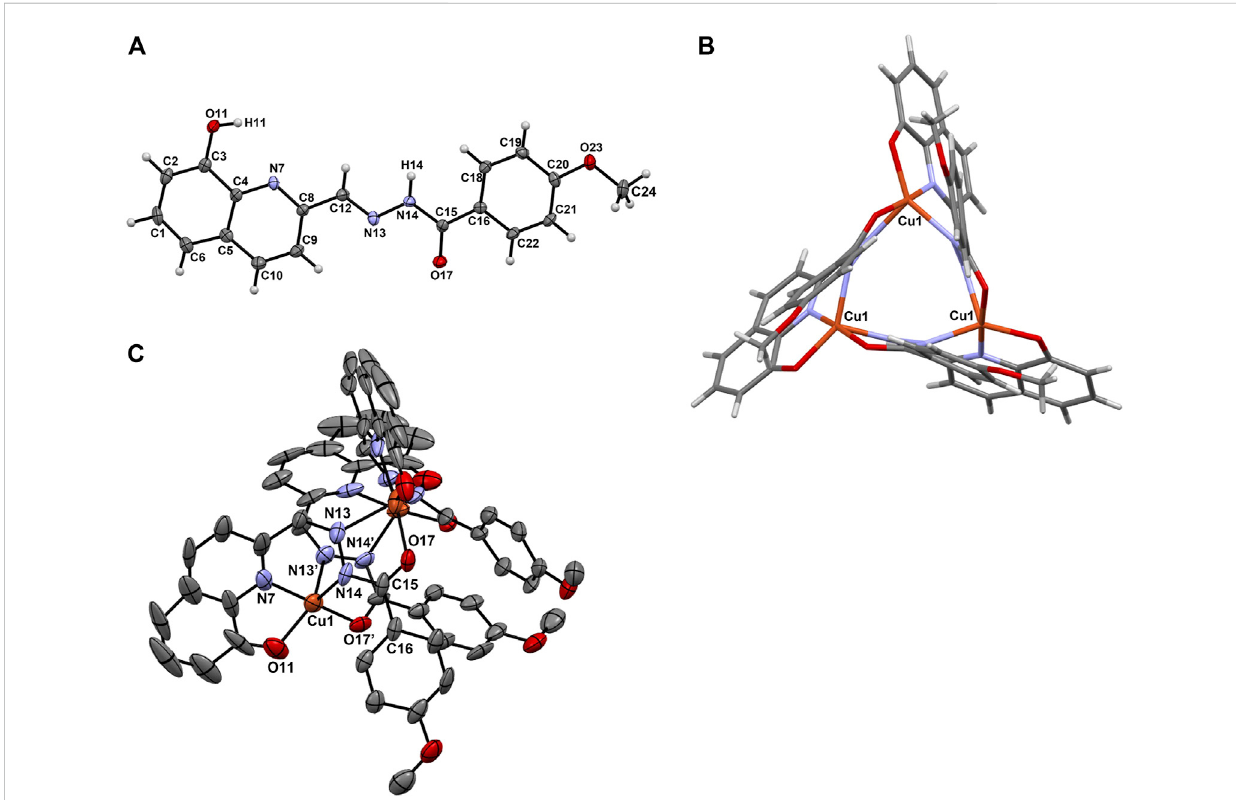
FIGURE 1 (A) ORTEP diagram of L 5 with thermal ellipsoids at 40% probability level along with the atom numbering scheme; (B) View of the binding in the equilateral triangle formed between the Cu(II) centres in [Cu(L 5 )] 3 ( 5 ) and (C) ORTEP diagram of [Cu(L 5 )] 3 with thermal ellipsoids at 40% probability level. Hydrogen atoms are omitted for